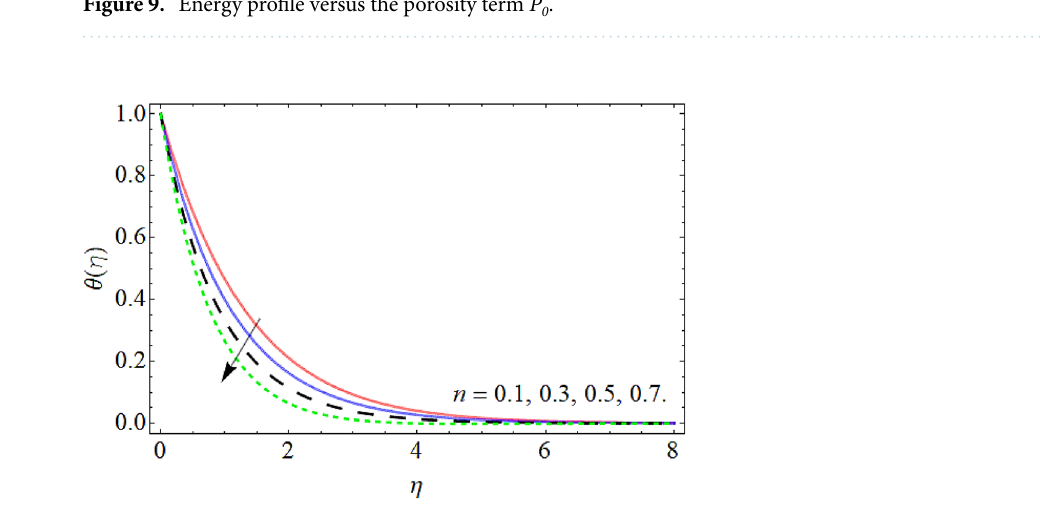
Figure 10. Energy profile versus the power law index n